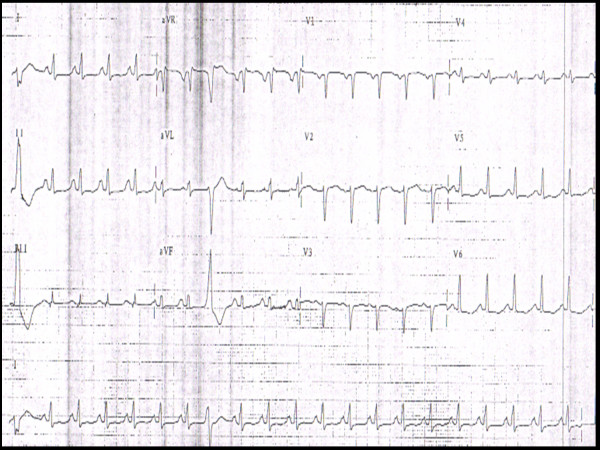
A 12-lead electrocardiogram showing sinus tachycardia, left atrial enlargement, poor R wave progression and nonspecific ST-T wave changes and T wave inversion in the lateral leads.